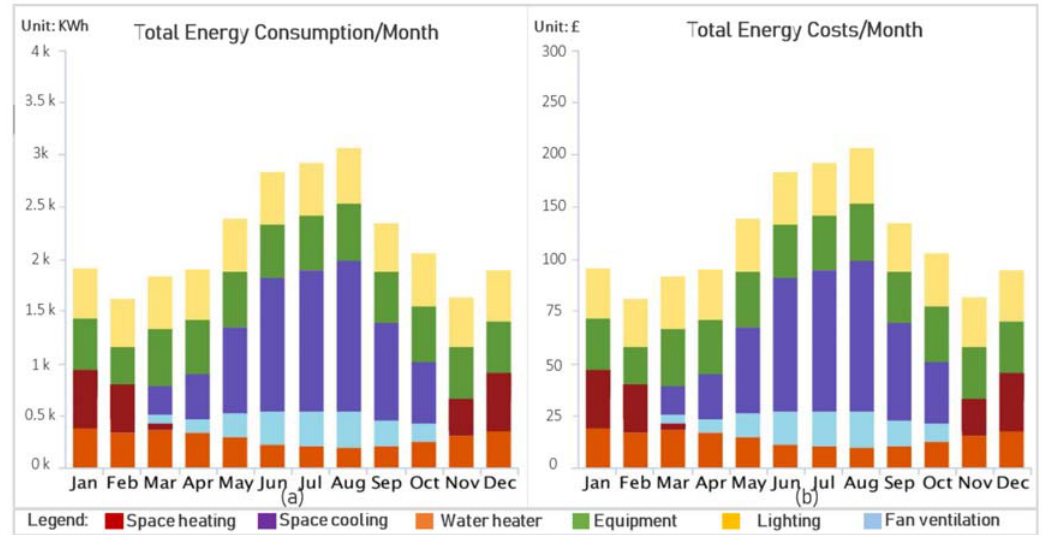
Figure 10. Prefabrication Unit: ( a ) Energy Consumption Analysis per Month, ( b ) Energy Costs per Month.